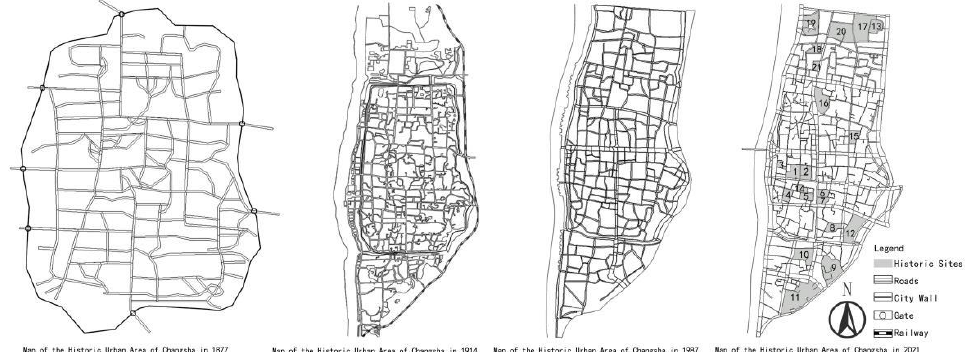
Figure 2. Maps of Various Periods.